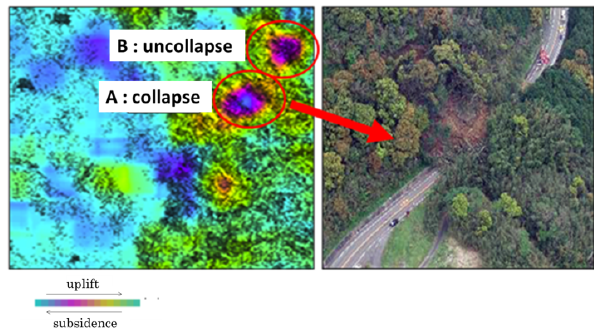
Figure 3. Imari area collapsed point (A) and uncollapsed point (B) were extracted based on InSAR analysis (left image). Actual spot of the collapse (right photo).